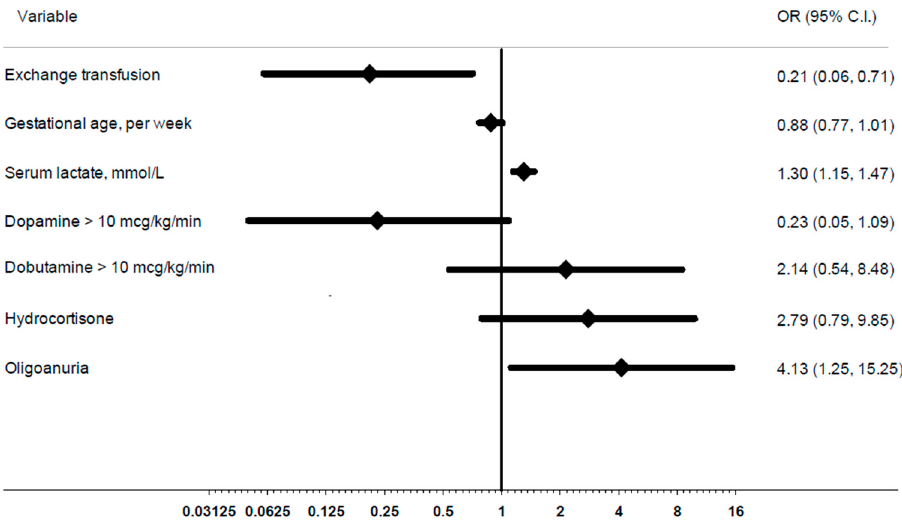
Figure 1. Adjusted odds ratios (ORs) (diamond) of death and 95% confidence intervals (CI) (bold line) in neonates who underwent exchange transfusion in comparison with the standard care therapy and according to selected clinical variables. Each variable is adjusted for the others.